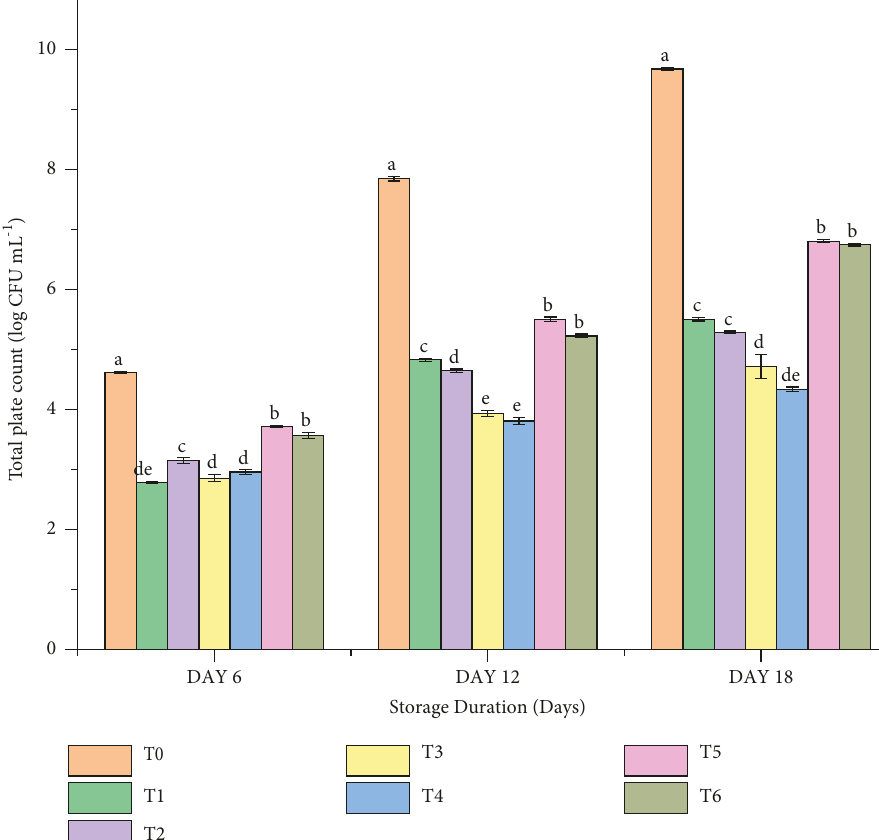
Figure 12: Effect of chitosan coating and cinnamon essential oil on total plate count (log CFUmL − 1 ) of pomegranate arils during storage at 4 ± 1 ° C. Vertical bars represent the mean ± SD of 3 replicates. Error bars with different small letters on the same storage period show a significant difference ( P ≤ 0 . 05). T0 � control; T1 � 1% chitosan+0.25% oil; T2 � 1% chitosan+0.5% oil; T3 � 2% chitosan+0.25% oil;